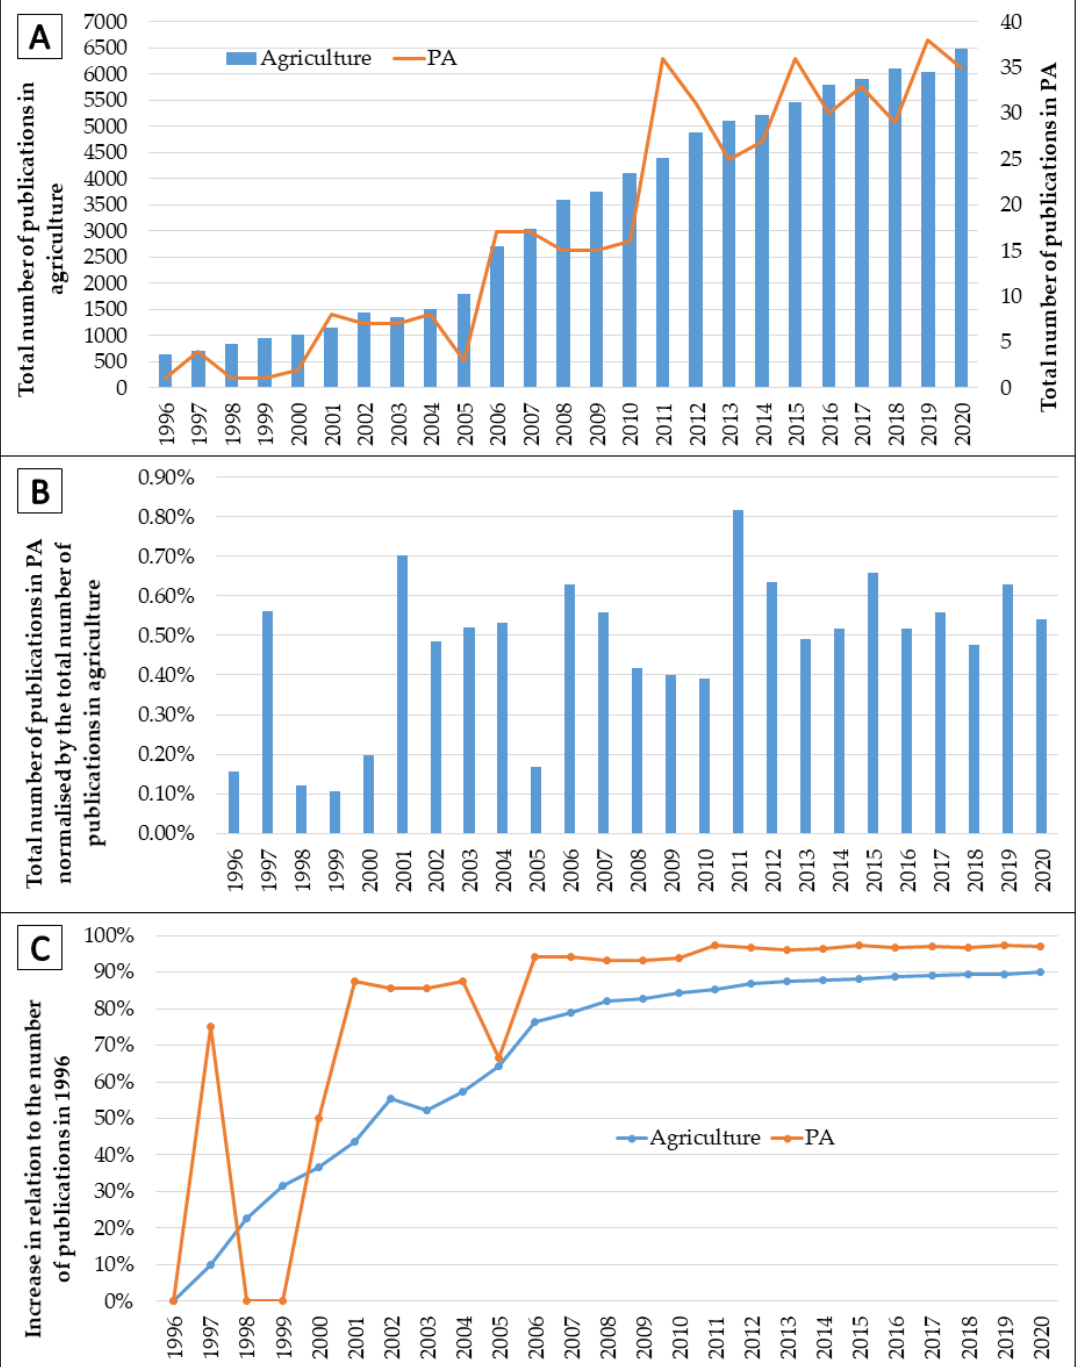
Figure A1. Evolution (from 1996 to 2020) of the total number of publications related to agriculture ( A ); evolution (from 1996 to 2020) of the total number of publications related to precision agriculture (PA) normalized by the total number of publications in agriculture ( B ); and increase in the percentage of the number of publications (in PA and agriculture) in relation to the year 1996 ( C ), the year of the first publication on PA in Brazil.